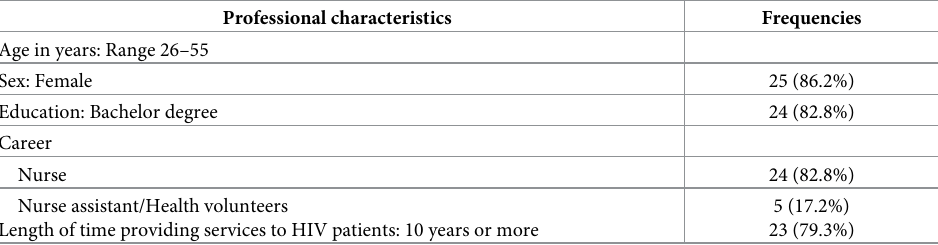
Table 4. Socio-demographic and professional characteristics of healthcare providers (N =